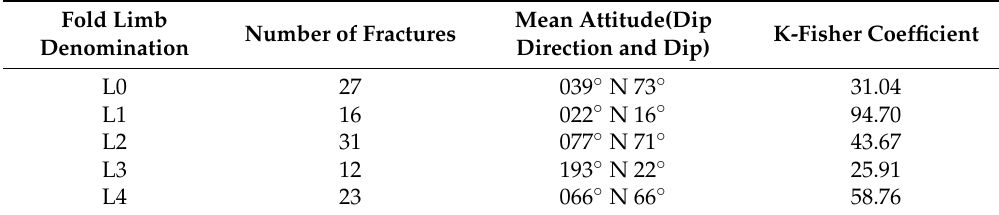
Table 10. Features of fracture set K3 determined in the different fold limbs.